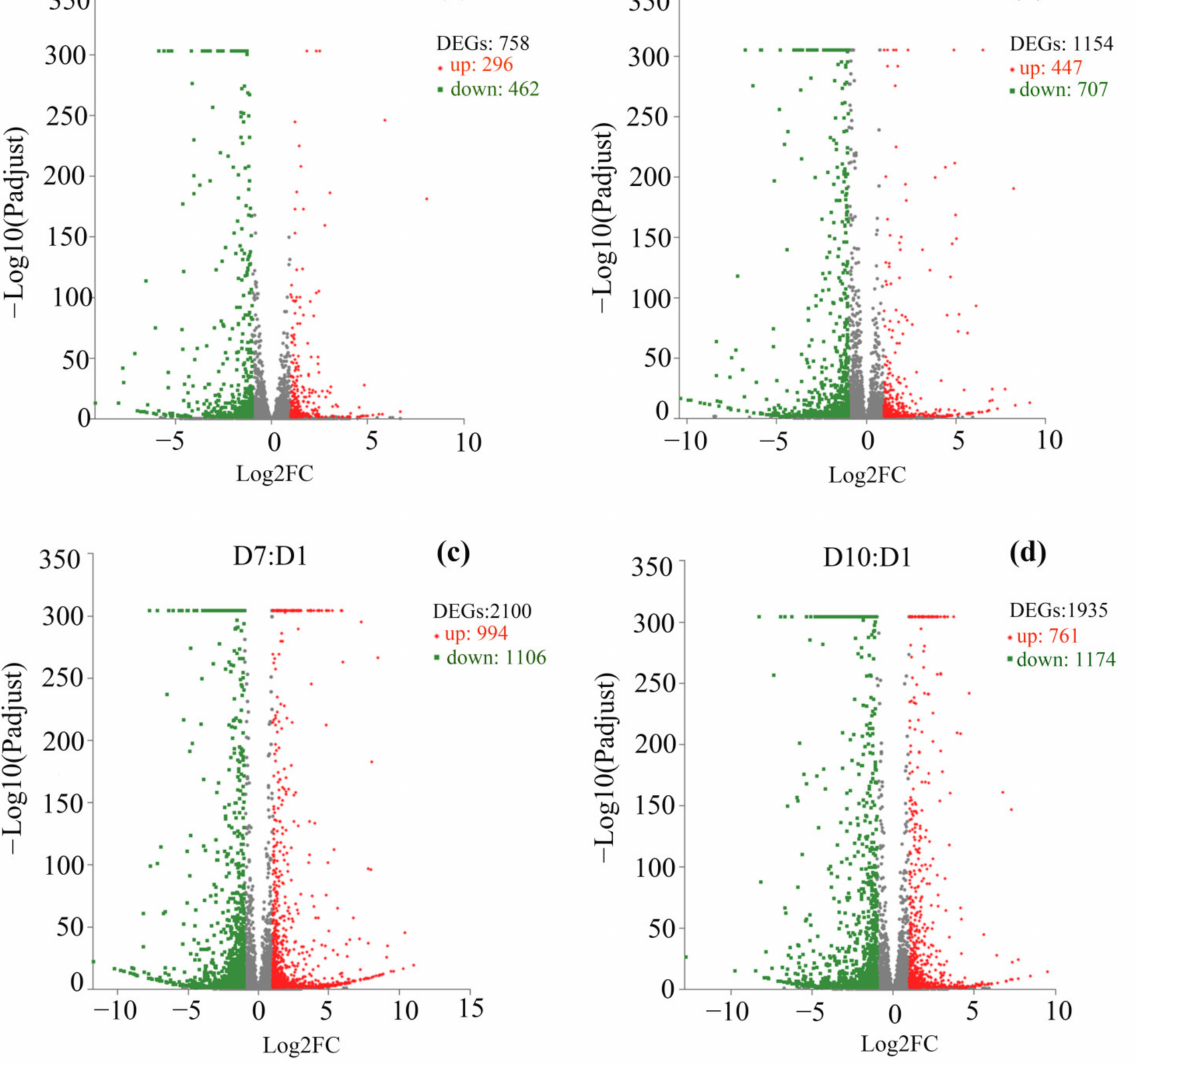
Figure 2. Volcano plots of DEGs from the flight muscle of S. frugiperda females. ( a – d ) are DEGs from the D3:D1, D4:D1, D7:D1 and D10:D1 groups, respectively. Genes with significant differential expression were indicated by red dots (upregulated) and green dots (downregulated). Genes with no significant differential expression were represented by gray